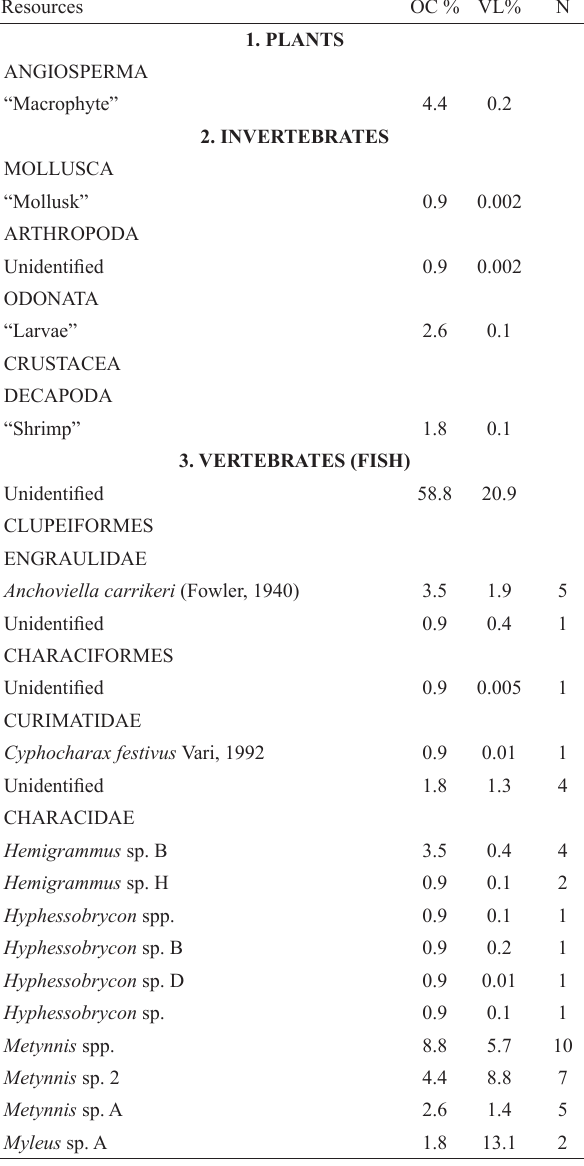
Table 2. Resources consumed by Cichla piquiti in Lajeado reservoir, rio Tocantins basin. The analysis is based on 114 stomachs. OC% = frequency of occurrence; VL% = relative volume; N = number of prey fish.